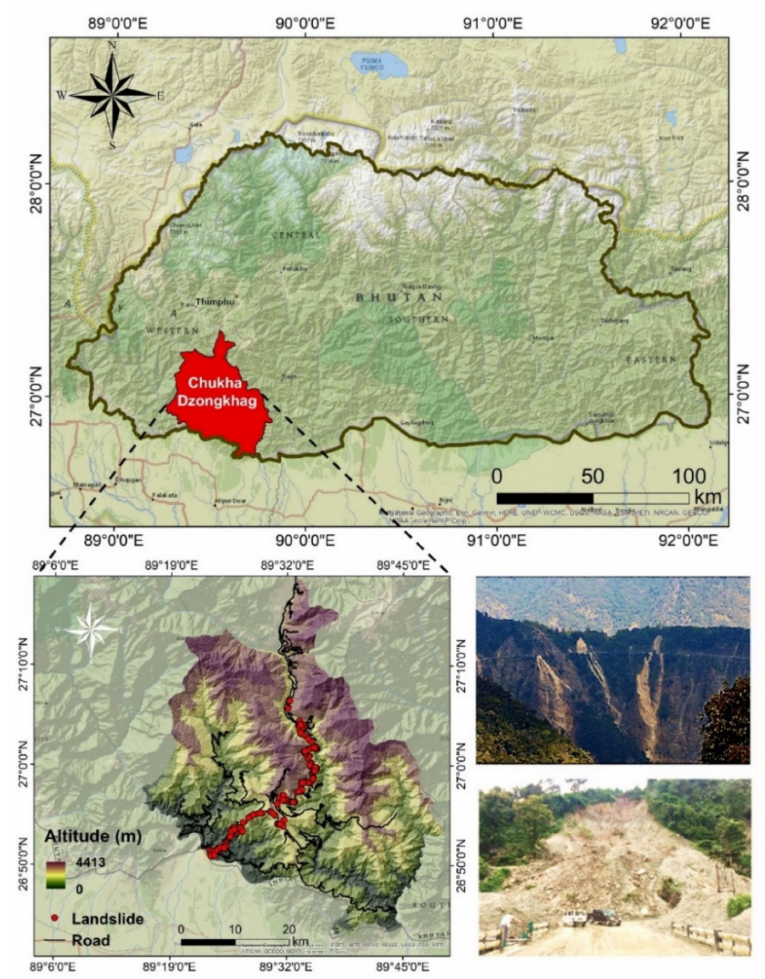
Figure 1. Location of the study area (Chukha Dzongkhag, Bhutan). Chukha Dzongkhag is located in a region with a subtropical and temperate climate. The area is highly prone to rainfall-induced landslides, exposed to an annual high level of rainfall (maximum of 4000–6000 mm), typically by 80% throughout the southwestern monsoon (from June to September). It records up to 800 mm · day − 1 as the most frequent heavy rainfall in the region. Landslides in the study area mostly occur due to intense monsoon rainfall, weak geology, and human-induced activities. The majority of land- slides occur along the Phuentsholing–Thimphu highway, a lifeline link that connects the capital Thimphu with neighbouring country India, by road as shown in Figure 1 [40,41]. Landslides often block the roads, thereby causing substantial damage to the economy and infrastructures. The geology of the area is characterised by Himalayan Crystalline